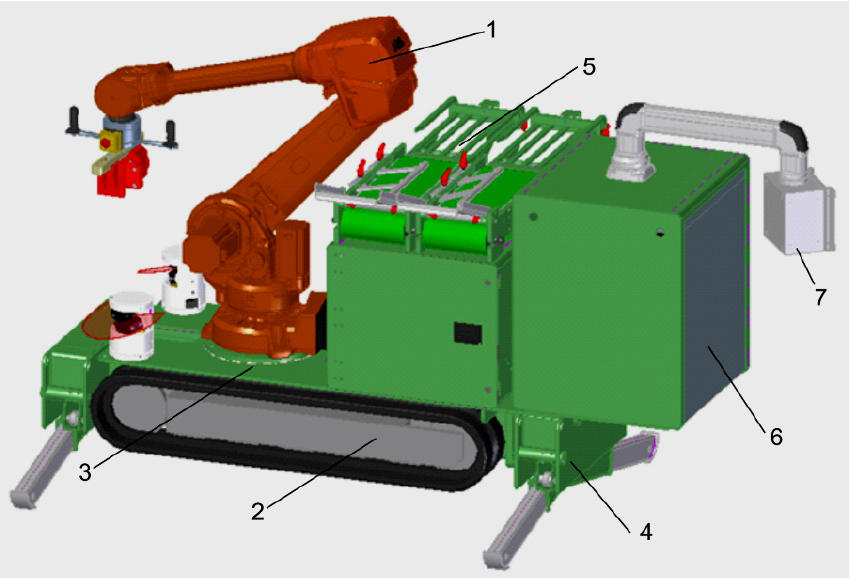
Figure 1. Three-dimensional model of mobile RBS. 1: bricklaying robot; 2: tracked undercarriage; 3: robot base platform; 4: hydraulic lifting and leveling module; 5: brick warehouse with brick feeder; 6: control cabinet; 7: control panel.